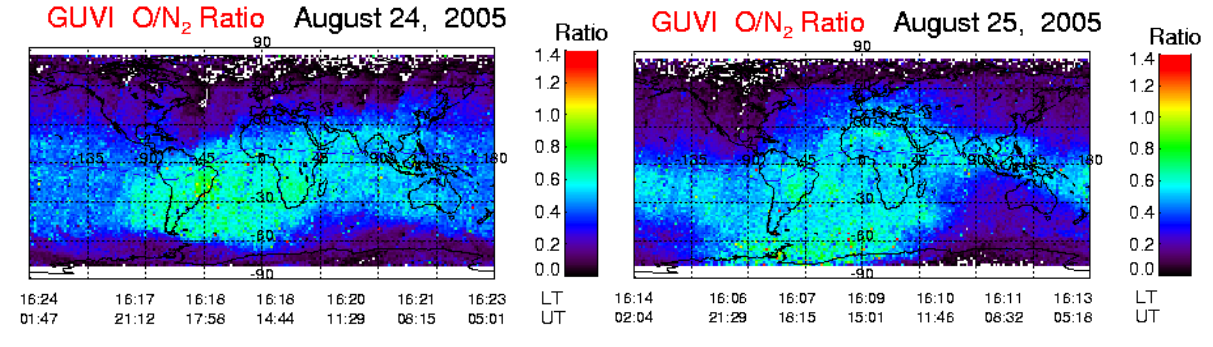
Fig. 7. TIMED/GUVI images showing thermospheric O/N 2 ratio during geomagnetic events of 24 and 25 August